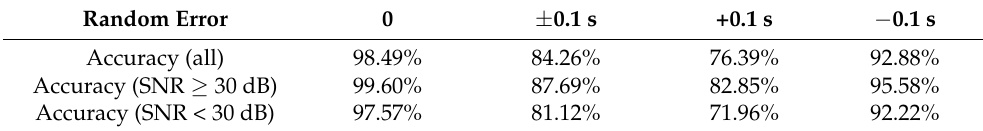
Table 2. Detection accuracy of P-wave first-motion polarity before and after shifting the arrival time.